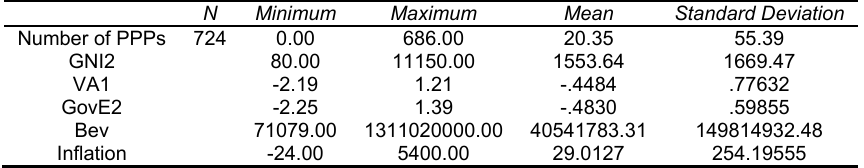
Table 1: Descriptive statistics N